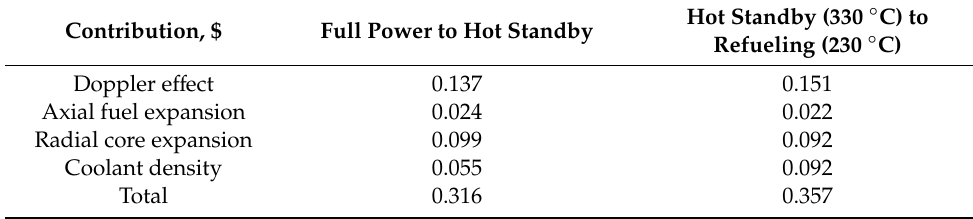
Table 7. Contributions to the temperature defect at